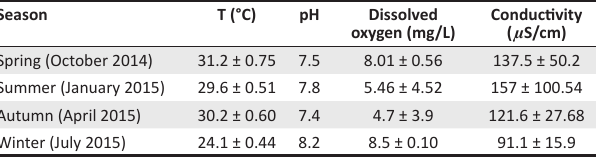
TABLE 3: Mean abundance of metazoan parasites infecting Hydrocynus vittatus ( n = 20) per season. Parasite